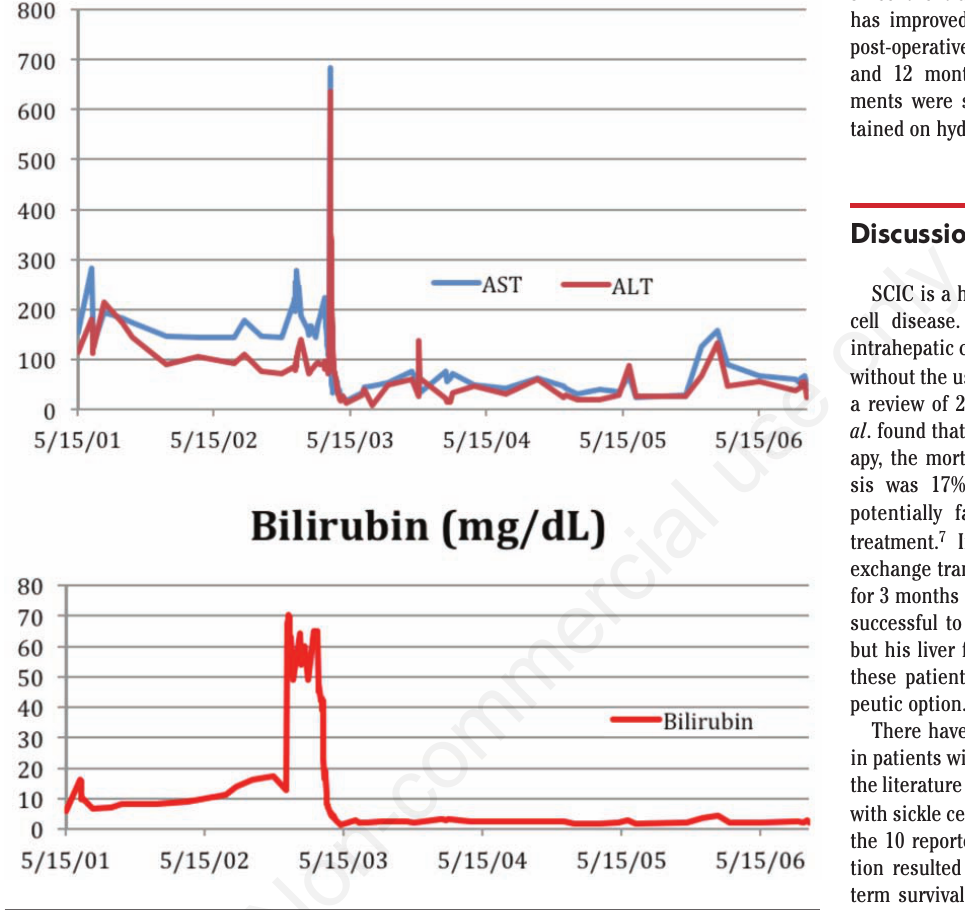
Figure 1. Aspartate aminotransferase/alanine aminotransferase (AST/ALT) (IU/L), and bilirubin (mg/dL).